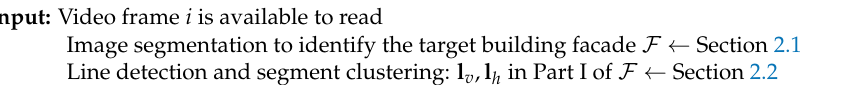
Table 1. Stratification of projective